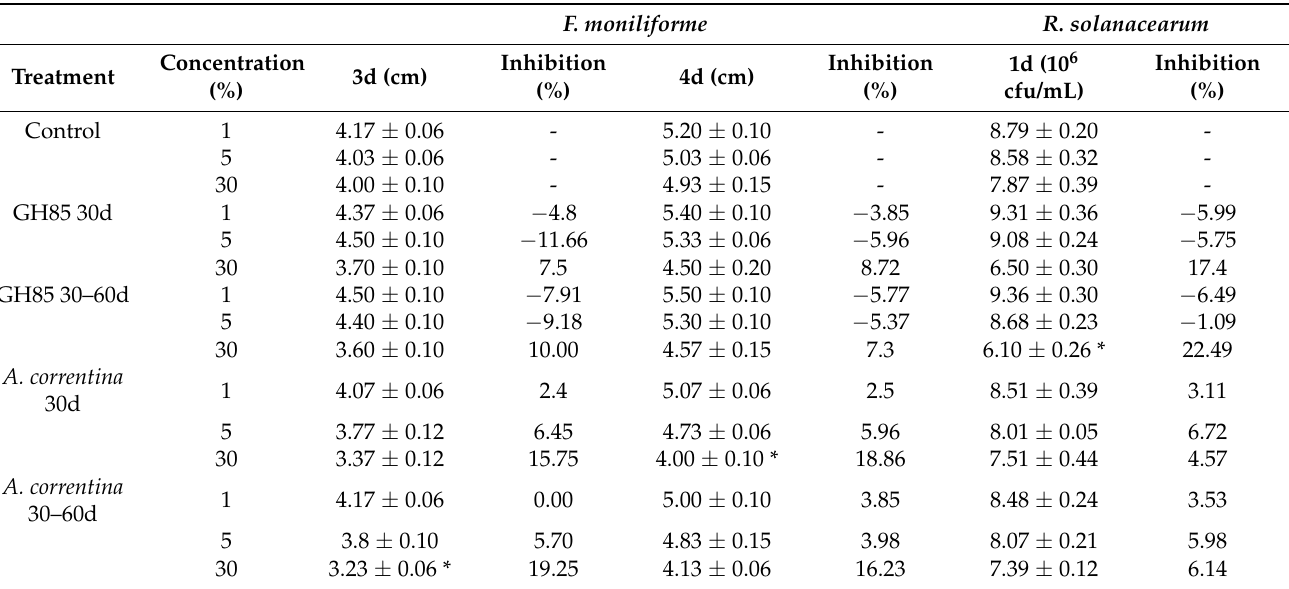
Table 1. Root exudates of peanuts interaction with R. solanacearum and F. moniliforme . F. moniliforme R.